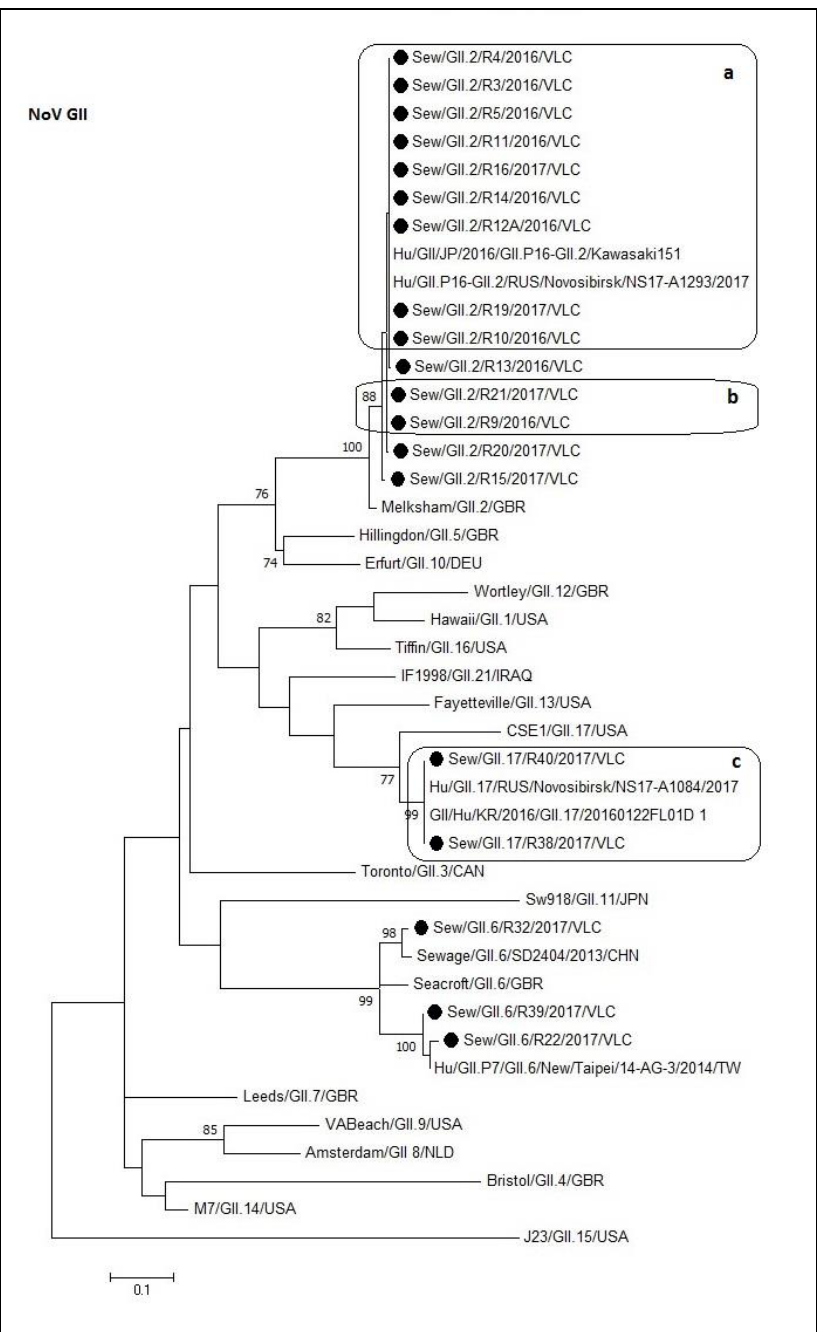
Figure 3. Molecular phylogenetic analysis of norovirus GII capsid. The evolutionary history was inferred by using the Maximum Likelihood method based on the Kimura 2-parameter model [42] with a bootstrap of 1000 replicates. The tree is drawn to scale, the branch lengths measure the number of substitutions per site. The analysis included 43 nucleotide sequences. There were 273 positions in the final dataset including nucleotides from 5113 to 5386. a, b, and c: Boxes that contain identical sequences.